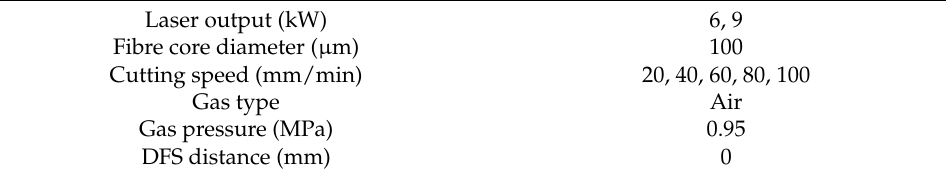
Table 2. Laser irradiation